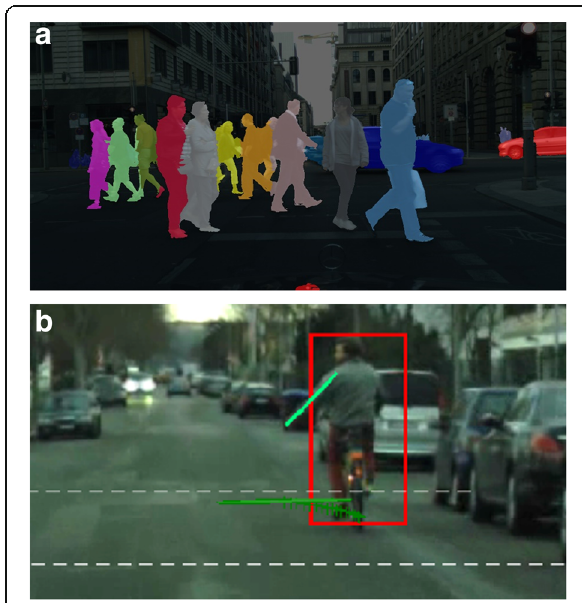
Fig. 1 In the future, it may be possible to not only a classify all individual road users in the environment (pixelwise instance segmentation [79] of an image from the Cityscapes Dataset [80]) but also to b predict their paths. The snapshot shows the predicted path (green curve) and position (green patch) of a cyclist (red box) 1 s into the future. Here, the cyclist is about to initiate a left turn at an intersection (horizontal dotted lines). From Kooij et al.